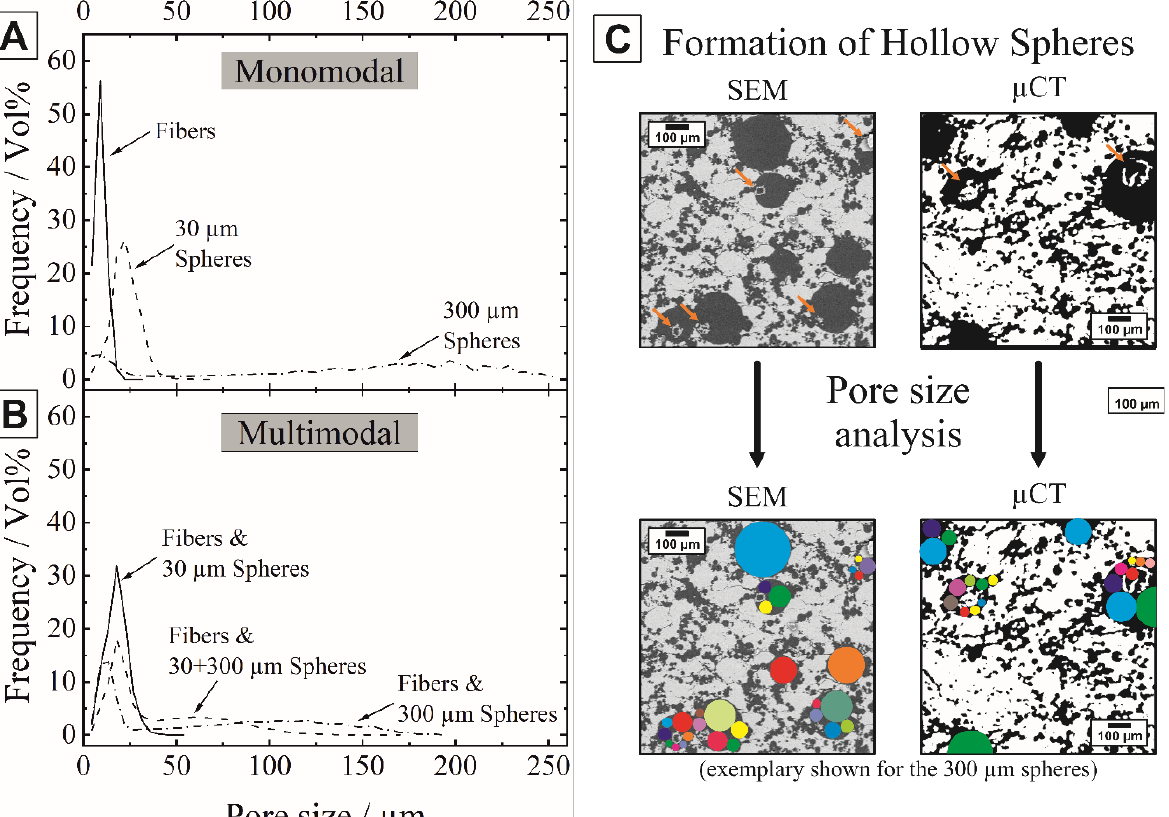
Figure 8. Pore size distributions of Al 2 O 3 ceramics with monomodal ( A ) and multimodal ( B ) pore size distributions derived from µ-CT analysis. The formation of hollow spheres inside the spherical pores leads to a reduced pore size and broadening of the pore size distributions ( C ).